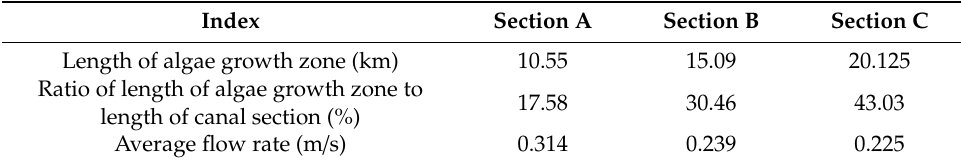
Table 2. Length of the algae growth zone and average flow